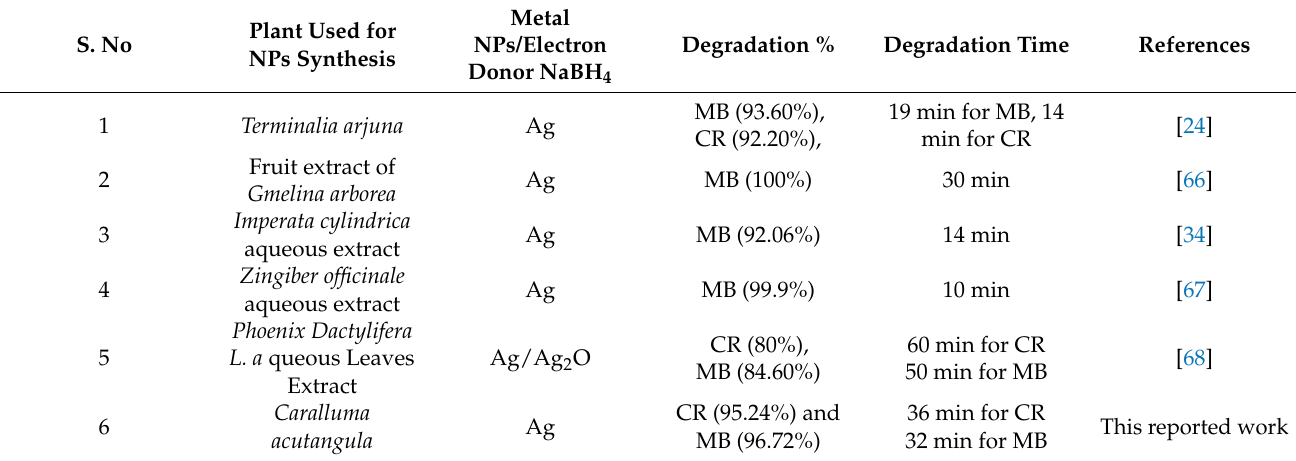
Table 3. Comparison of catalytic activity efficiency of CA-AgNPs for dye